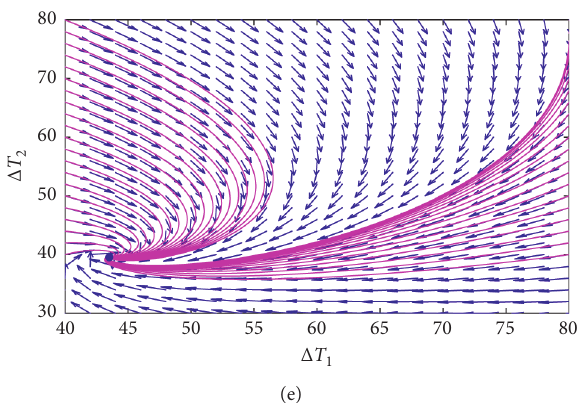
Figure 3: Phase portrait and vector field for scenario 1 ( k > 0): (a) k � 10 and α � 0.05 of realization 2; (b) k � 10 and α � 0. 5, where the red point and blue point denote the equilibrium point of realization 1 and realization 2, respectively; (c) k � 10 and α � 1 of realization 1; (d) k � 10 and α � 1 of realization 2; (e) k � 10 and α � 2 of realization 1.